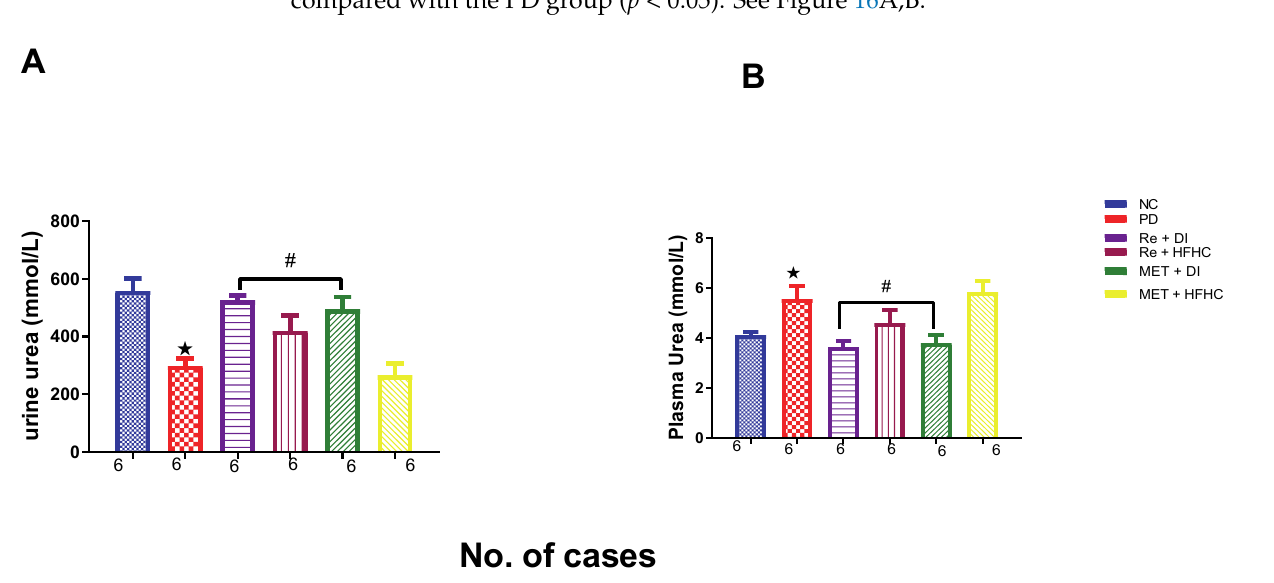
compared with the PD group ( p < 0.05). See Figure 16A,B.